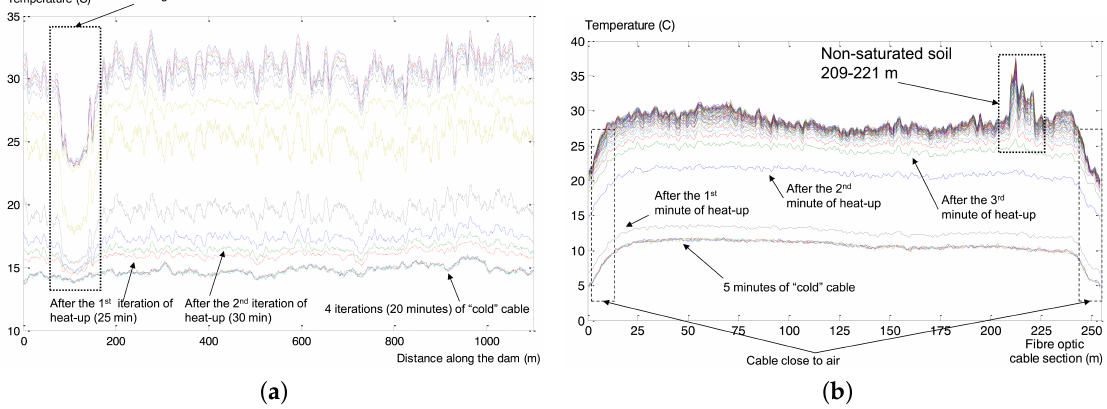
Figure 8. Fibre-optic cable heat-up in time (colours correspond to different time stamps). ( a ) Leakage is detected at the section where the temperature drops due to a larger thermal conductivity value of the soil; ( b ) Non-saturated soil region is detected at the section showing a larger temperature increment corresponding to a smaller thermal conductivity value of the soil. Reproduced with permission from